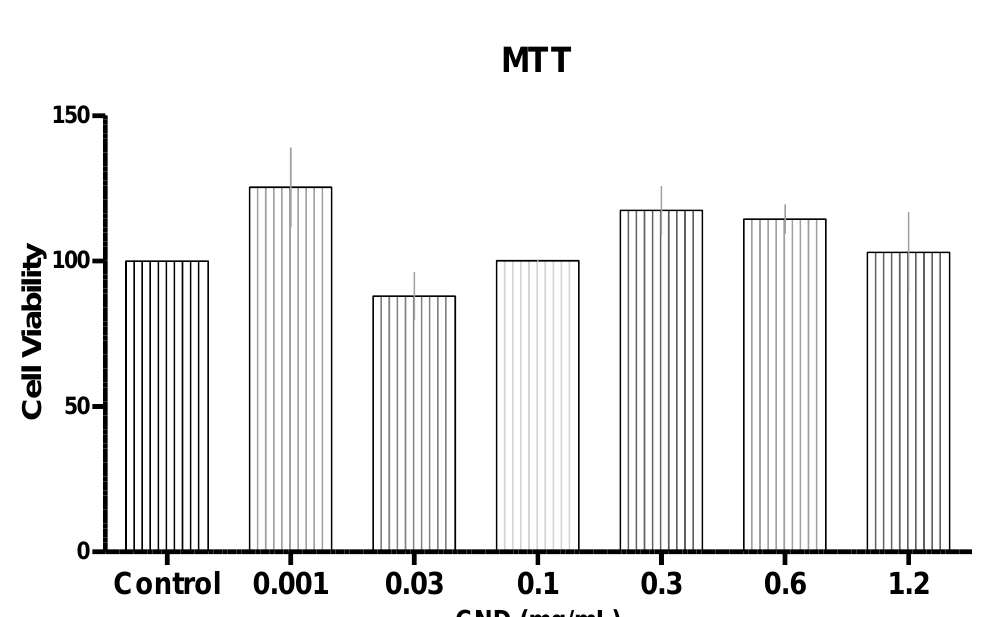
Figure 2. Cell viability with MTT assay. HMEC-1 cells were treated with varying concentrations of CNDs for 6 h. After treatment, cells were washed two times with PBS, and cells were treated with MTT dye for two hours. After two-hour incubation, purple formazan was dissolved in DMSO. Bio-Tek ® Synergy plate reader was used at 570 nm to determine colorimetric reading. No significant change in cell viability was determined to occur. All data represent mean ± SEM. (n = 3, p > 0.05 vs. control).